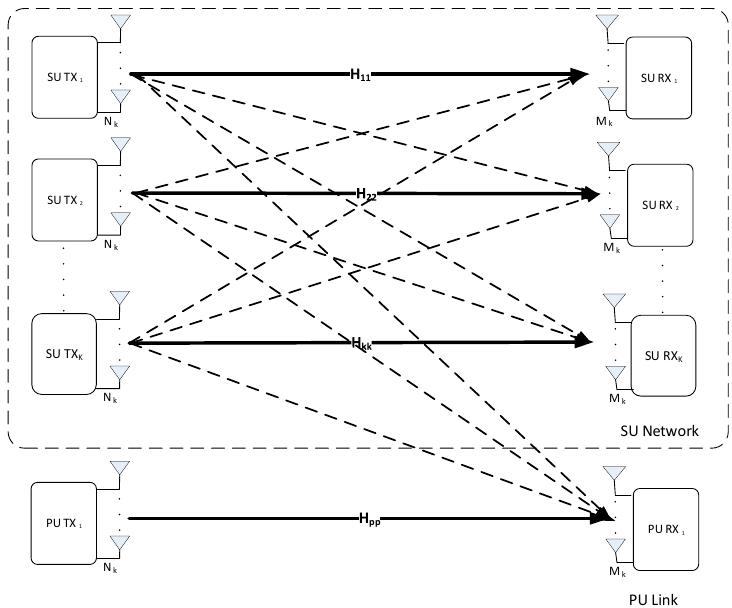
Figure 2. Multiuser cognitive radio (CR) network model consisting of one primary user (PU) link and multiple secondary users (SUs)—Paradigm 1.